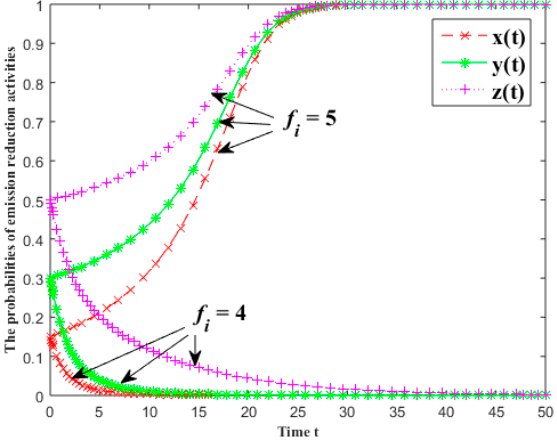
Figure 5. The effects of the basic returns on the probabilities of emission reduction activities.